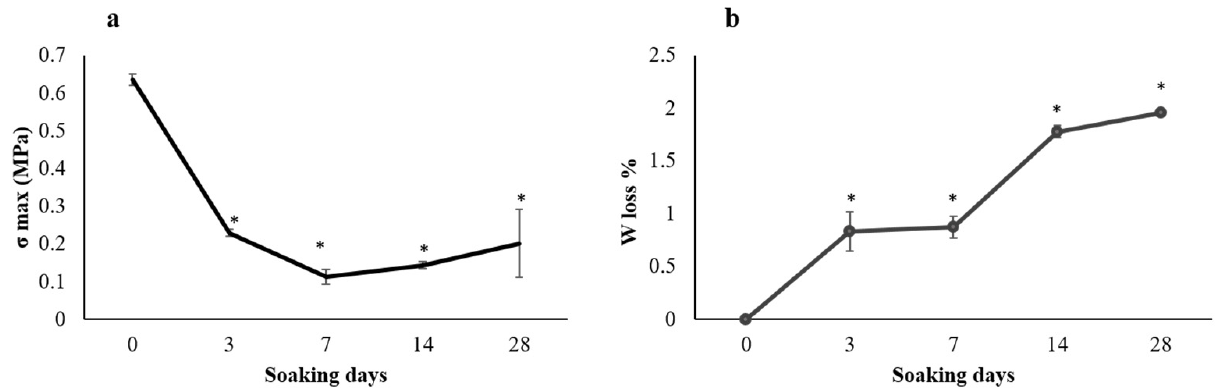
Figure 2. Plot of ( a ) mechanical strength and ( b ) weight loss% during soaking in Tris-HCl. Average values ± SD, n = 6. * p < 0.05 compared to 0 days.